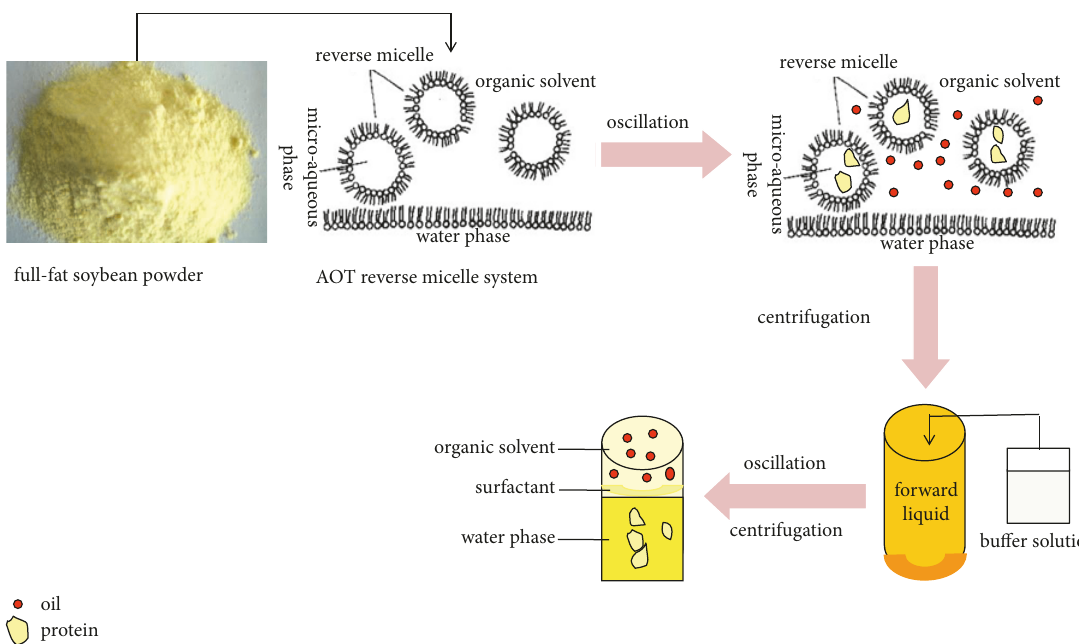
Figure 1: Schematic illustration of the extraction of oil and protein by AOT reverse